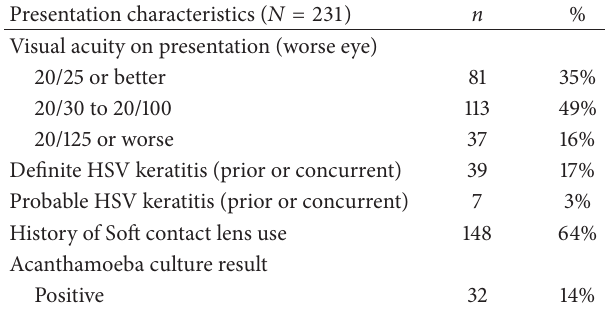
Table 1: Clinical characteristics and concurrent ocular conditions on presentation or referral.